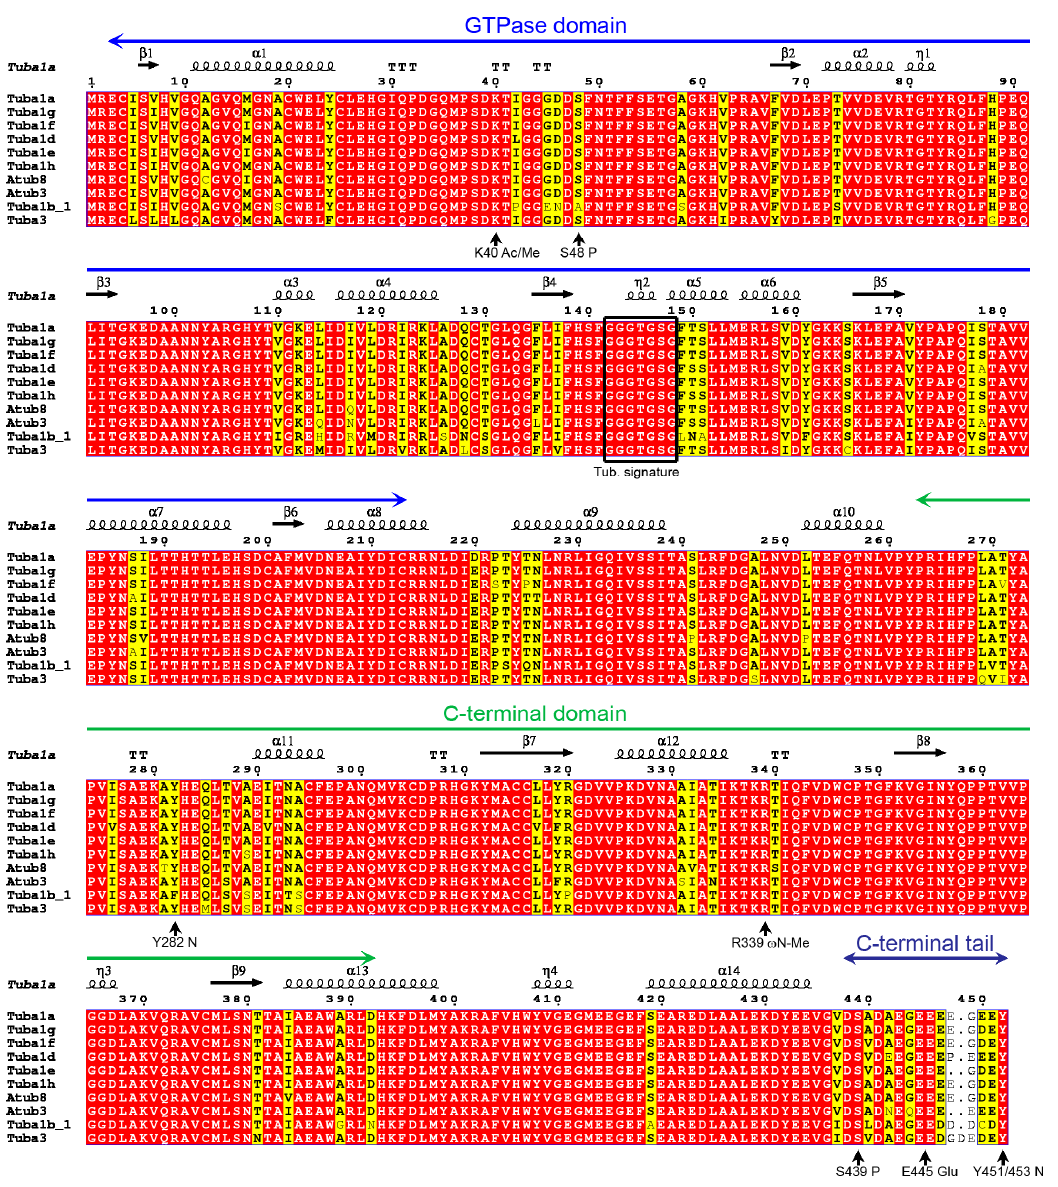
Figure 1. Multiple sequence alignment (MSA) of the α -tubulins of P. lividus . Alignment was performed with T-coffee and rendered by ESPript 3.0. Similar residues are written in black bold characters and boxed in yellow whereas conserved residues are in white bold characters and boxed in red. The sequence numbering on the top refers to the alignment. Tubulin domains are highlighted by long arrows also on the top. The principals PTMs are indicated on the bottom. Ac: acetylation; Me: methylation; P: phosphorylation; Glu: polyglutamylation and polyglycylation.